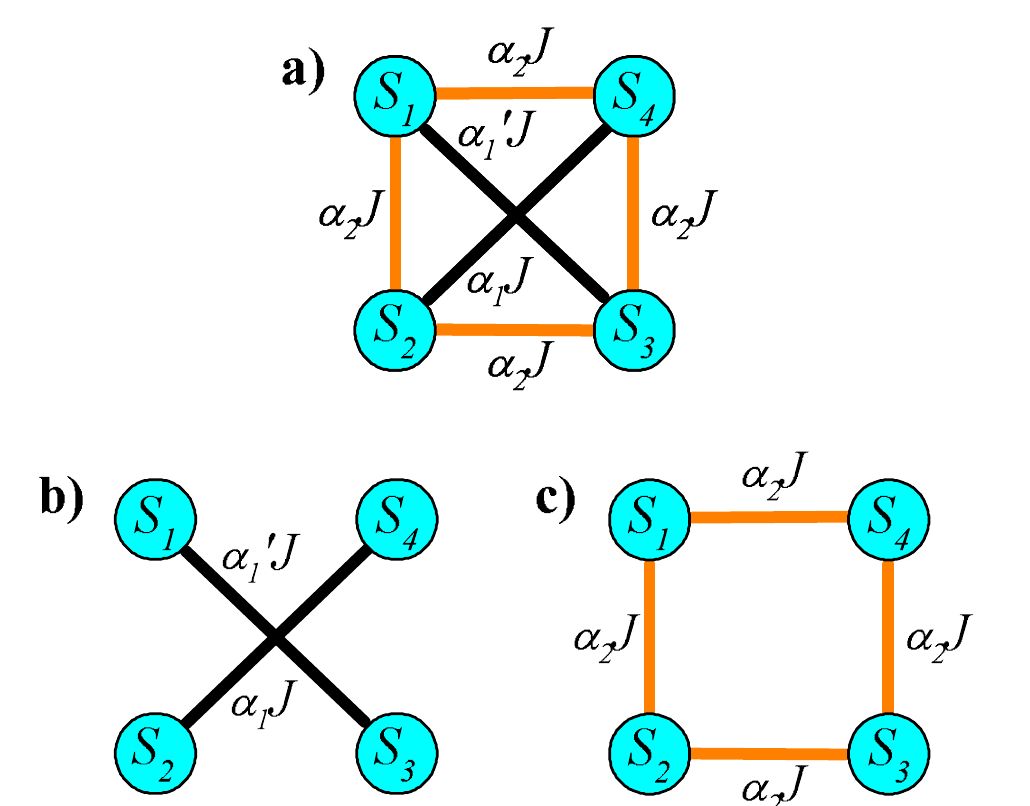
Figure 1. The general representation of the tetramer. Each constituent atom has a spin value that couples to two other atoms via an exchange interaction α i J , where α i is the scaling parameter of interaction strength. ( a ) The coupled tetramer that contains dimer pairs S d 1 and S d 2 . S d 1 is formed between S 1 and S 3 , whereas S d 2 is formed between S 2 and S 4 . It also contains dimer–dimer interactions along the outside edges of the tetramer; ( b ) The uncoupled dimer configuration is formed = 0. It is important to note when α 2 = 0; ( c ) The square configuration is formed when α 1 = α (cid:48) 1 that, while we show this structure as a square, the spatial configuration is not relevant as only the magnetic spin interactions are considered in the energy